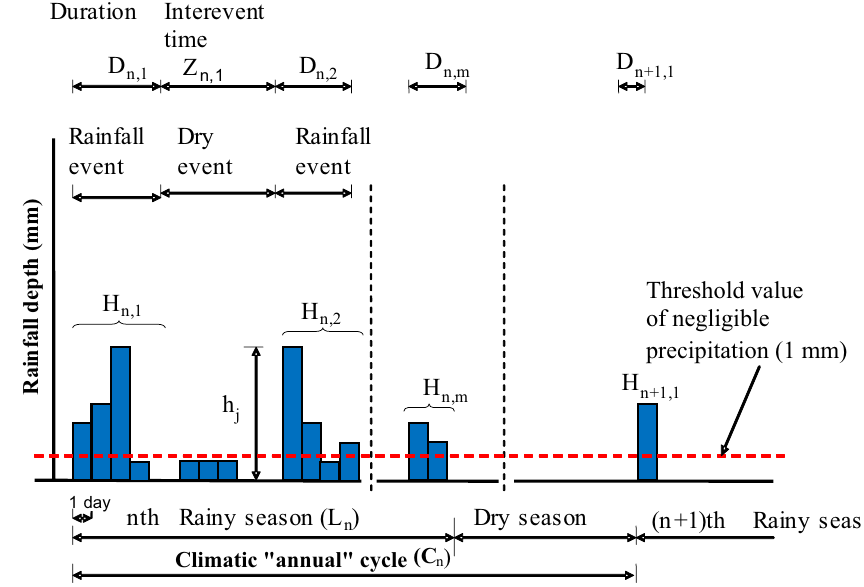
Fig. 4 Representation of the climatic cycle. Legend : m : the index m refers to the m th event (spell) of the nth rainy season; D : duration of m th n,m wet (rainfall) spell in a n th rainy season symbolizing the num- ber of subsequent rainy days; H : total accumulated rainfall n,m depth of D rainy days in n,m